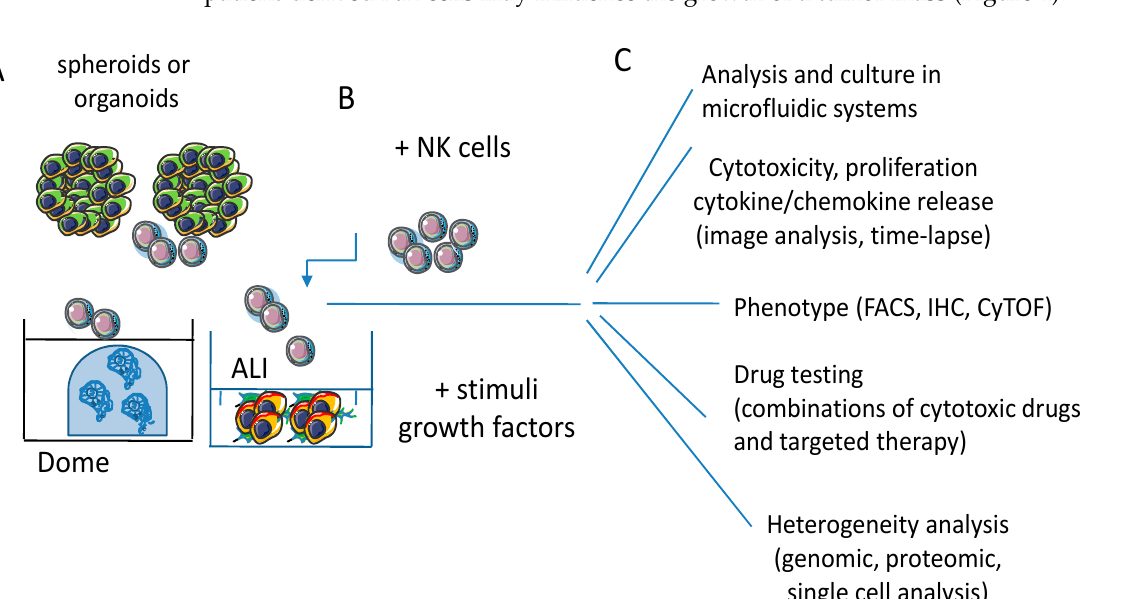
Figure 4. 3D culture models for NK/effector-tumor cell interaction. ( A ) Spheroids and organoids allow a more holistic approach to study the interactions between tumor and effector cells, provided the use of chemically defined media with components that do not alter the phenotypic and functional features of epithelial cells and lymphocytes and avoid factors that can metabolically inhibit one or another of these two cell populations. ( B ) The use of specific stimuli such as growth factors or cytokines can mimic in vivo conditions like in conventional cultures. The 3D structure of tumor mass forces the lymphocytes to interact with tumor cells and penetrate into spheroids and/or organoids. This interaction should trigger mechanisms of lymphocyte invasion, while also tumor cells respond to this trigger. ( C ) Endpoints and assays involved in effector lymphocyte/tumor cell 3D cultures analysis. NK/effector cell-mediated cytotoxicity and cytokine release through imaging software tools and time-lapse recording, including computerized microfluidic systems. NK/effector cell phenotype can be assessed using different methodological approaches, such as fluorescence activated cell sorting (FACS), immunohistochemistry (IHC) or mass cytofluorimetry (CyTOF). Drug testing, including combinatorial drug regimens, can be performed evaluating spheroid/organoid size and the differences of metabolism and oxygenation of the tumor mass, as it happens in vivo. The response of tumor cells, as well as that of NK cells, can be analyzed in detail applying genomic and proteomic analysis at the single cell level upon the disaggregation of the 3D culture model.